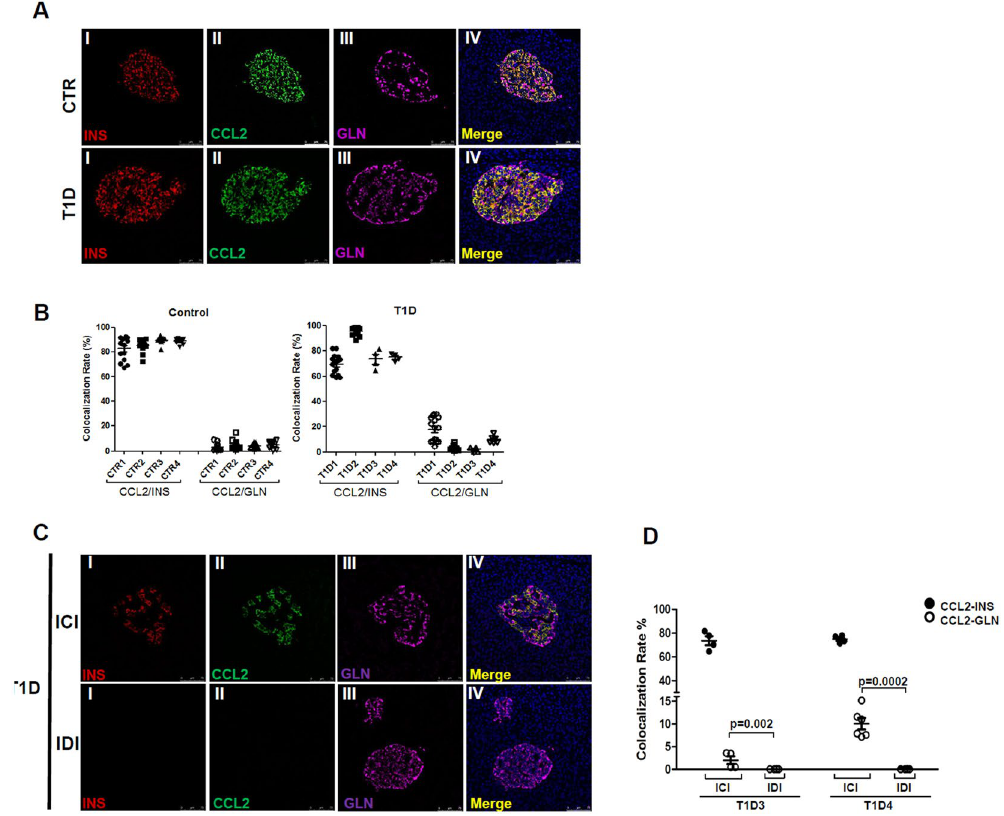
Figure 5. CCL2 is primarily expressed by insulin-producing cells in pancreatic islets. ( A ) Representative images of CCL2 immunofluorescence staining on human pancreatic sections from non-diabetic donors (upper panels) and from subjects with T1D (lower panels). Overlapping signals between CCL2 (green) and insulin (red) staining is shown in panel IV; low/absent overlap was seen with CCL2 and glucagon (magenta) stainings. Scale bar 75 µ m. ( B ) Colocalization analysis between CCL2/Insulin and CCL2/Glucagon in non-diabetic donors (left panel) and in patients with T1D (right panels). Values are reported as mean ± SEM of the percentage of colocalization rate values. Each dot represents a single colocalization rate value obtained per single analyzed islet. ( C ) Representative images of CCL2 immunofluorescence on human pancreatic sections from T1D donors in Insulin-Containing Islets (ICI)- upper panel- and in Insulin-Deficient Islets (IDI)- lower panel- Scale bar 75 µ m. ( D ) Colocalization analysis between CCL2/Insulin (black filled circle) and CCL2/Glucagon (empty circle) in two T1D donors by separately taking into consideration ICI and IDI. Values are reported as mean ± SEM of the percentage of colocalization rate values. Each dot represents a single colocalization rate value obtained per single analyzed islet. p < 0.05 non-parametric Mann-Whitney U test